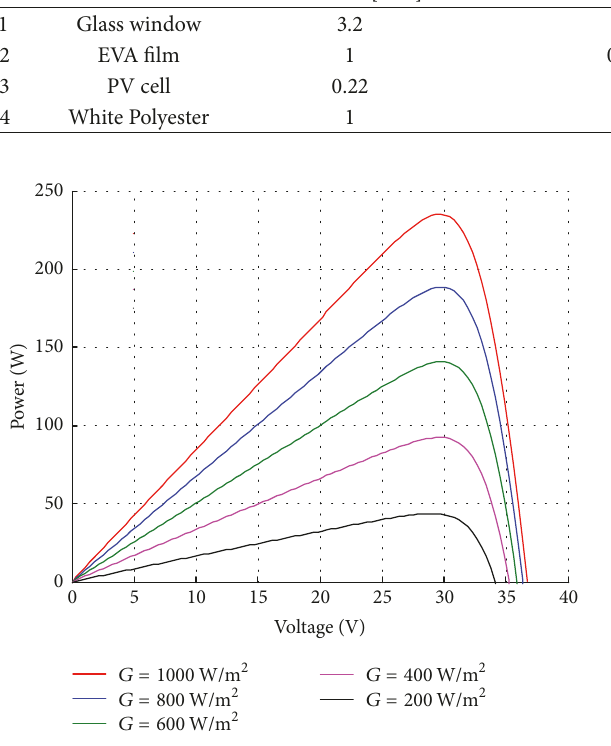
Figure 8: 𝐼 - 𝑉 curves for different cell temperatures.